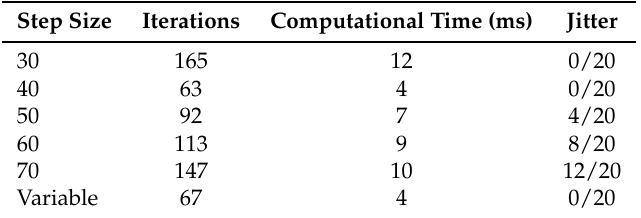
Table 2. Demonstration of the efficiency of the proposed variable RRT method.